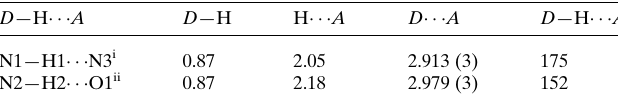
Table 1 Hydrogen-bond geometry (A˚ , (cid:2) ).